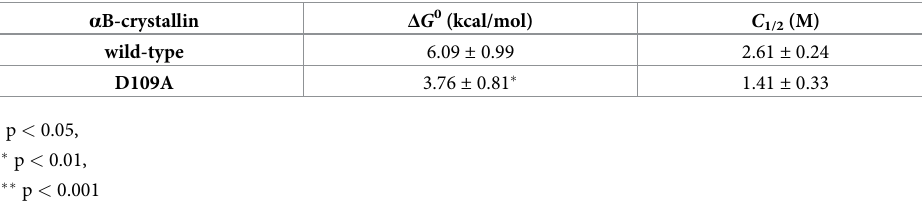
Table 3. Δ G 0 and C 1/2 values of different α B-crystallin samples which obtained from the equilibrium urea unfold- ing